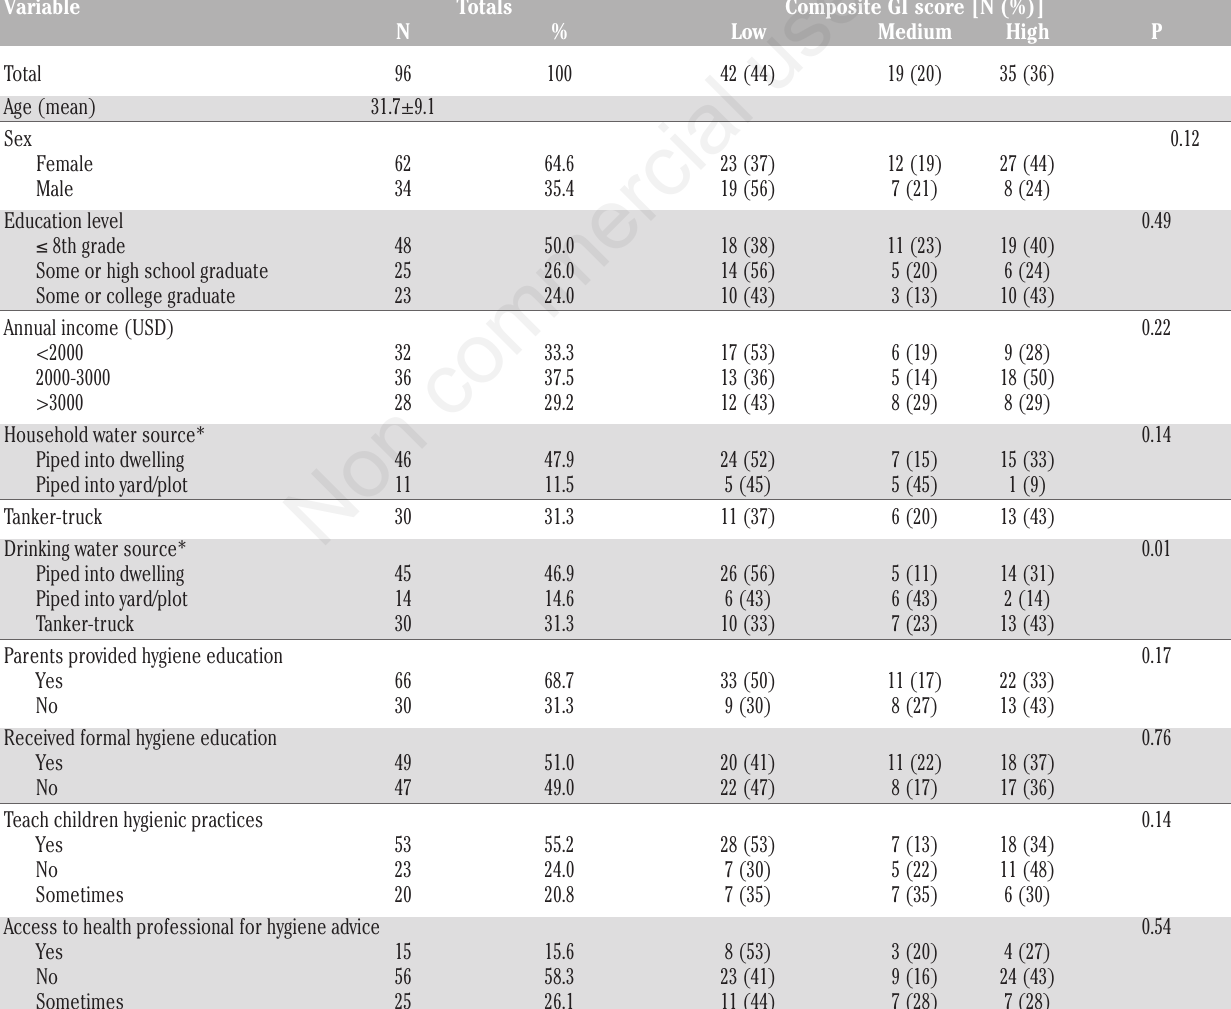
Table 1. Total distribution of water/personal hygiene education variables of interest and distribution of these same variables across indi- vidual and household gastrointestinal cases (case is defined as having 2 or more episodes of diarrheal and emesis).